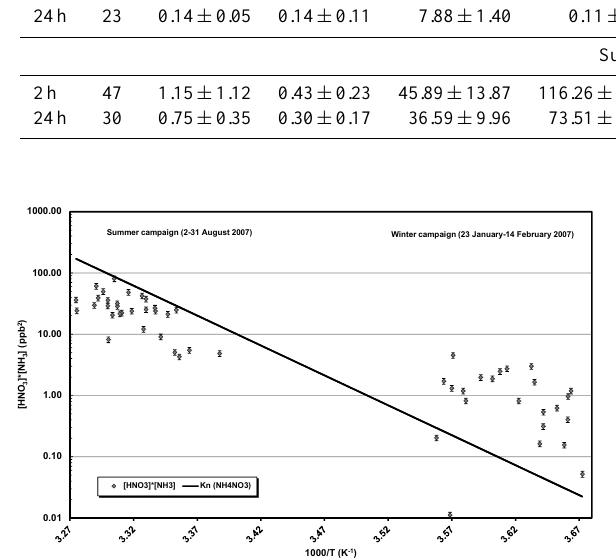
Fig. 5. Thermodynamically predicted equilibrium dissociation con- stant K n (black solid line) for pure NH 4 NO 3 and measured concen- tration product K mn =[HNO 3 ][NH 3 ] as a function of temperature for winter (right side) and summer (left side) seasons at Beijing. The K n and K mn constants have been determined by data collected on a 24-h